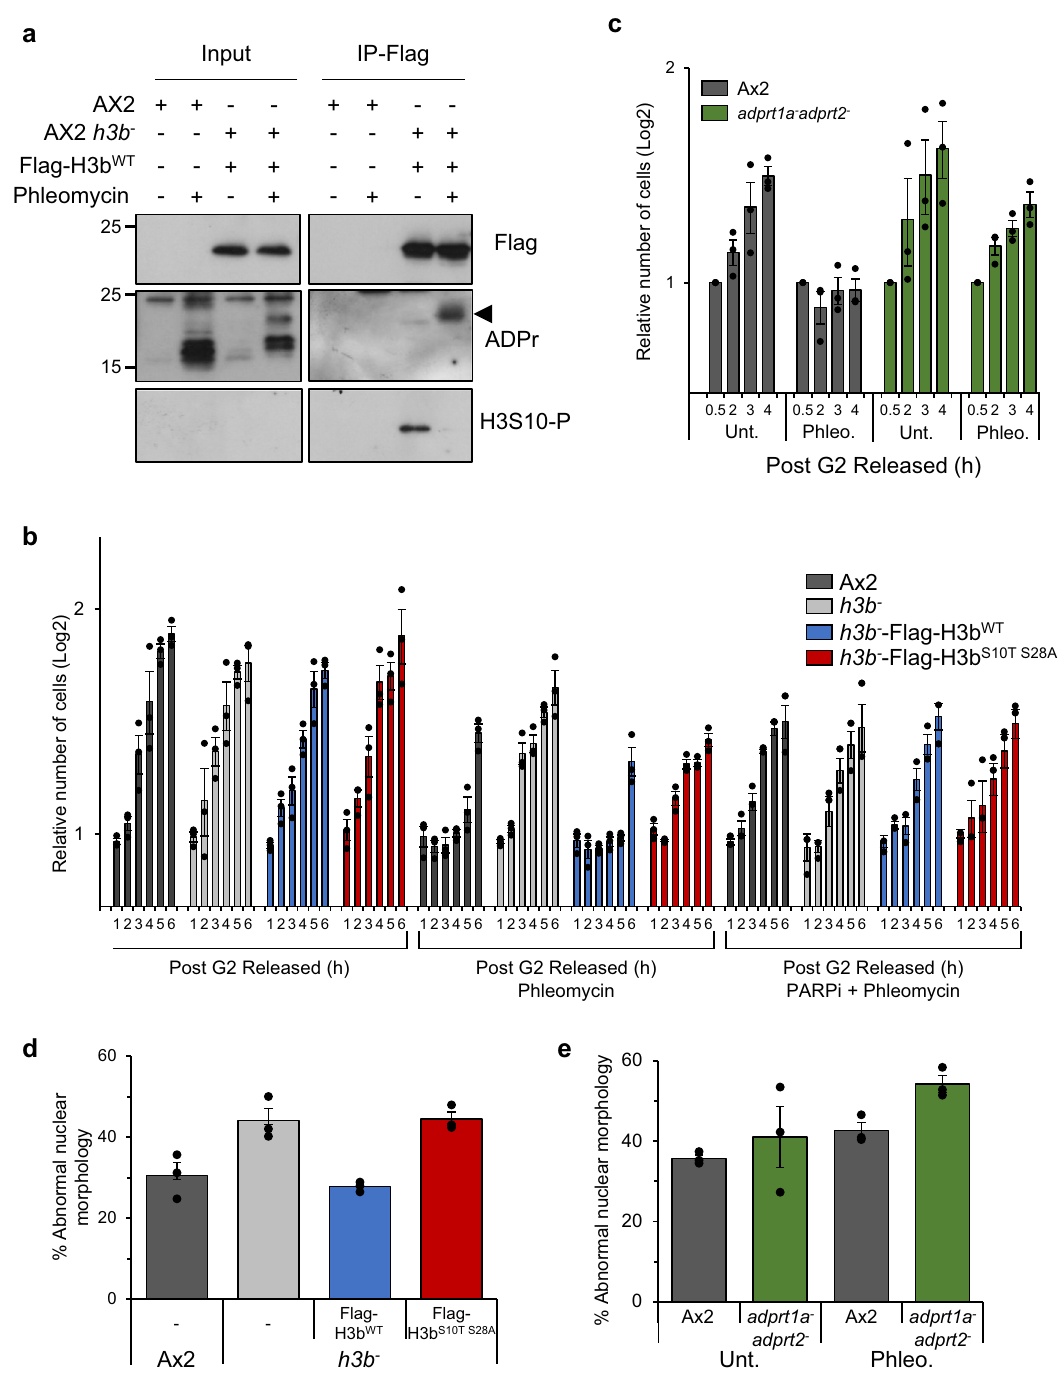
Fig. 5 H3b ADP-ribosylation is required to suppress premature mitotic entry with DNA damage. a Ax2 or h3b − cells expressing Flag-H3b WT or Flag- H3b S10TS28A were left untreated or exposed to phleomycin as indicated. Western blotting of Flag-immunoprecipitates was performed using the indicated antibodies. Molecular weight markers are indicated in kDa. b Ax2, h3b − cells, or h3b − cells expressing Flag-H3b WT or Flag-H3b S10T S28A were arrested in G2 and following treatment or not with phleomycin in the absence or presence of olaparib, released into fresh media to allow resumption of the cell cycle. Progression through mitosis was monitored by assessing cell number at times following release from G2. c Ax2 and adprt1a − adprt2 − cells were arrested in G2 and following treatment or not with phleomycin assessed for mitotic entry as described in ( b ). d Ax2, h3b − cells and h3b − cells expressing Flag-H3b WT or Flag-H3b S10TS28A were treated with a transient exposure to phleomycin for one h and after 48 h of recovery abnormal nuclear morphology assessed by experiments. Individual data points are shown and error bars represent the SEM. Source data are provided in the Source Data fi